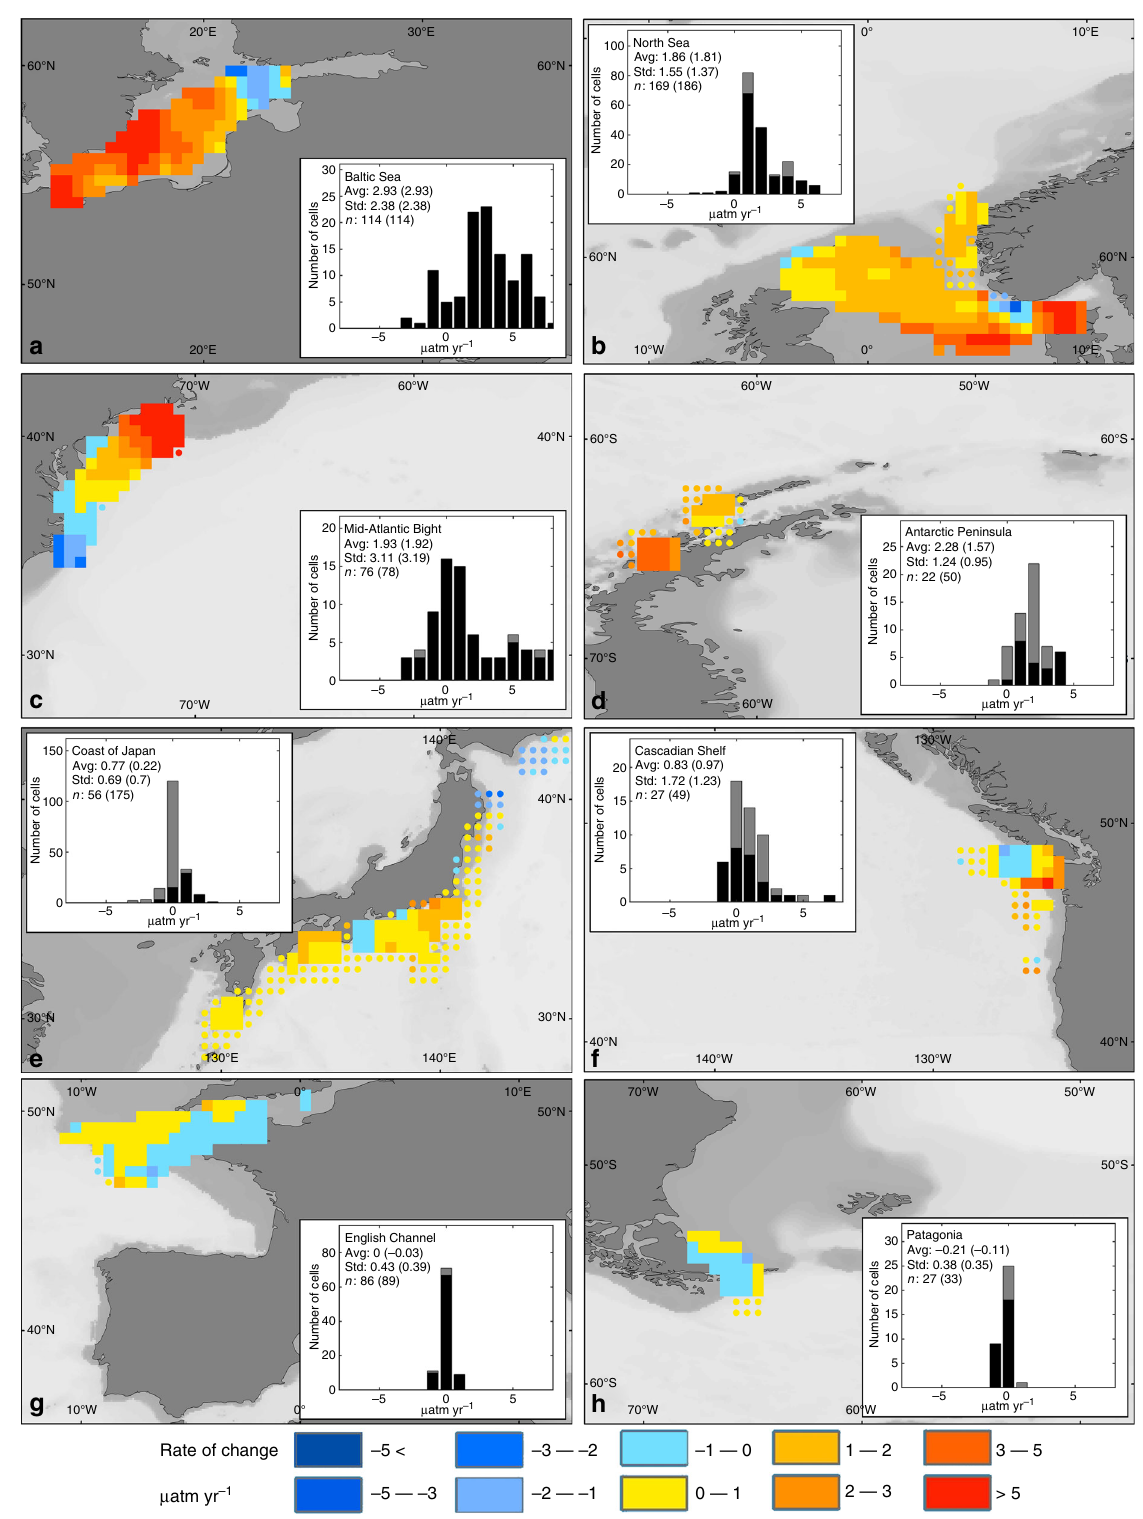
Fig. 1 Rate of increase in winter air – sea p CO 2 gradient for selected best surveyed continental shelf regions. a Baltic Sea, b North Sea, c Mid-Atlantic Bight, d Antarctic Peninsula, e Coast of Japan, f Cascadian shelf, g English Channel, and h Patagonia. Each point represents a 0.5°x0.5° cell. Cells belonging to the narrow and wide de fi nition of the shelf are displayed as squares and diamonds, respectively. The inserted histogram provides the distribution of the average d( Δ p CO 2 )/d t value, standard deviation, and the number of cells using the narrow (black lines) and wide (gray lines and numbers in brackets) de fi nitions of the